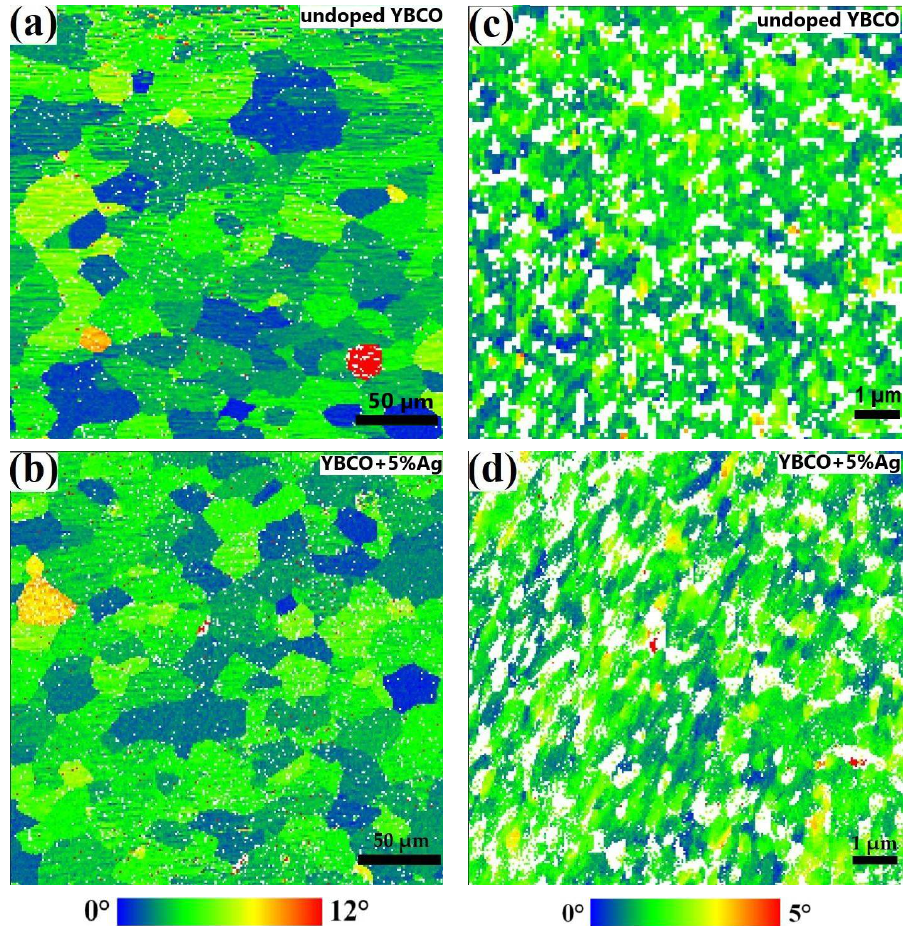
Figure 2. EBSD maps of the absolute misorientation from the ideal cube texture without noise reduction for undoped and Ag-doped YBCO films on ( a , b ) RABiTS (step size 1.0 µm) and ( c , d ) IBAD−MgO (step size 0.02 µm). White dots are non-indexed areas .